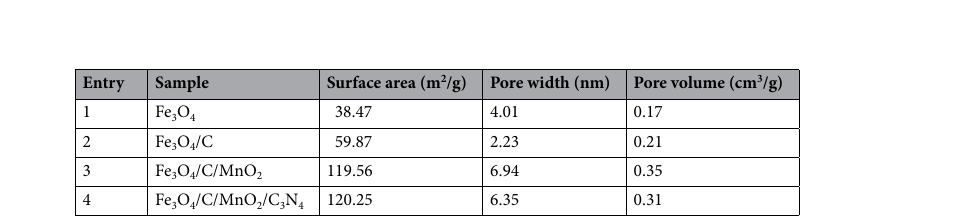
Table 1. Specific surface area and pore parameters of